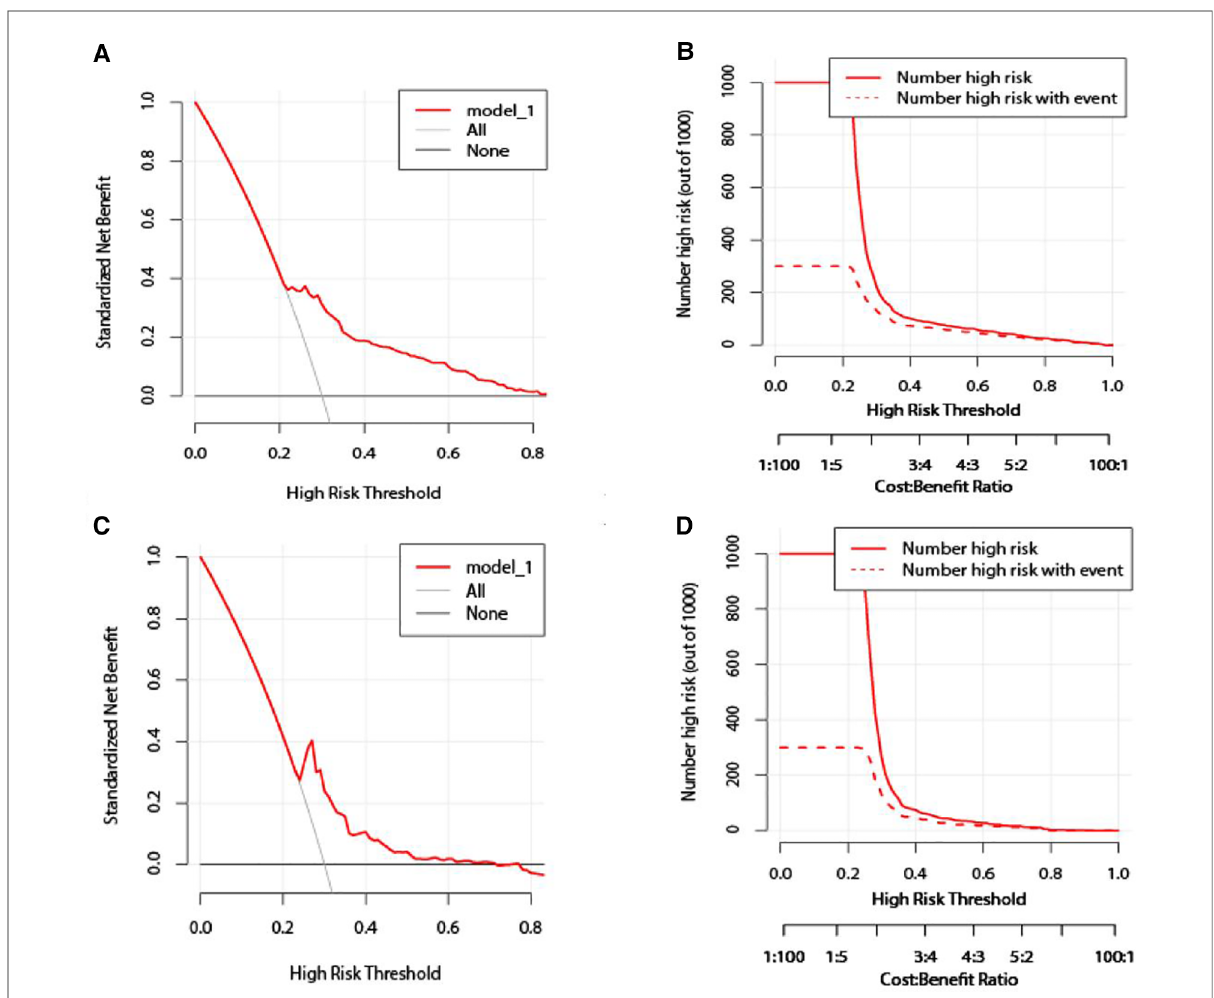
FIGURE 4 Validation of the column line graph prediction model. ( A,C ) Modeling group/validation group DCA decision curve; ( B,D ) modeling group/validation group clinical impact